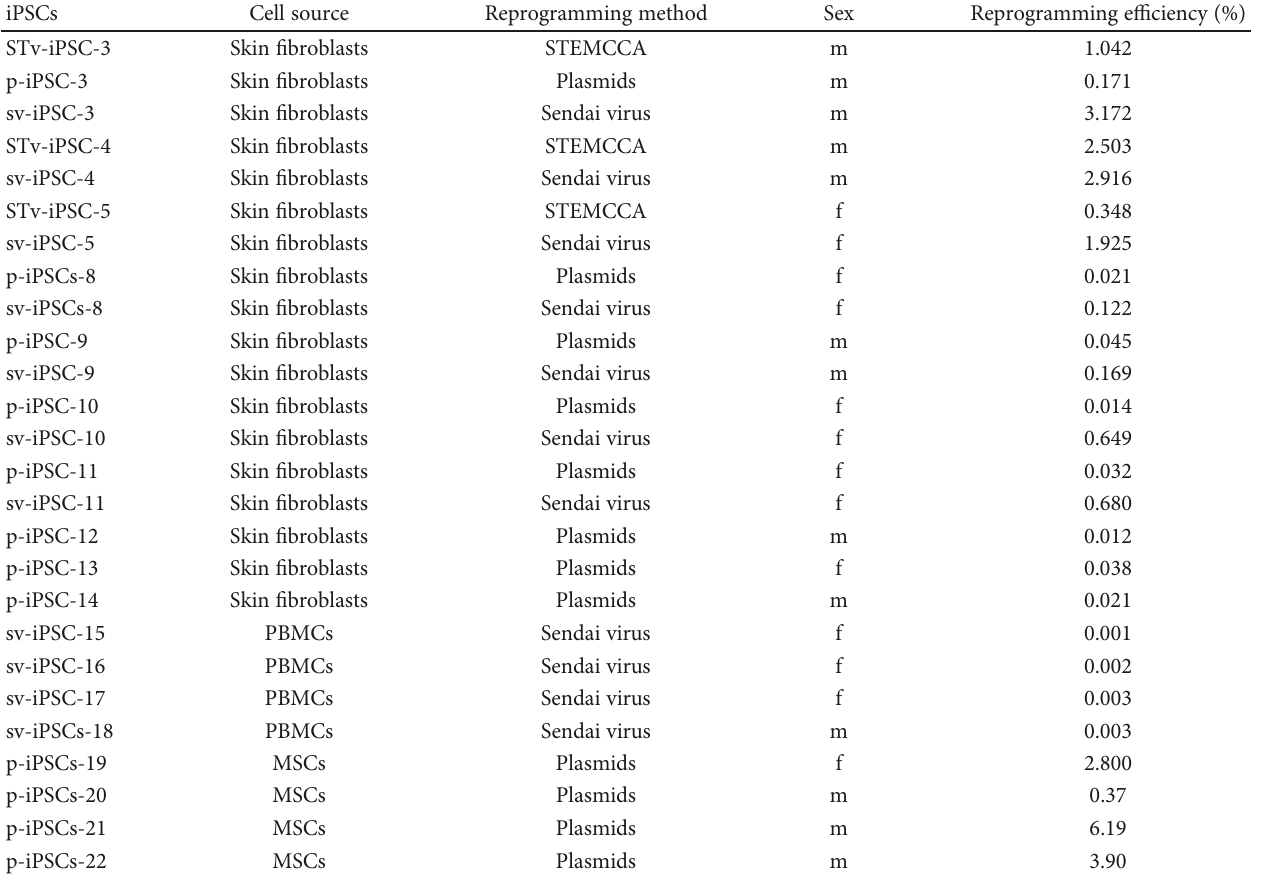
Table 2: Cell lines used in this study for reprogramming e ffi